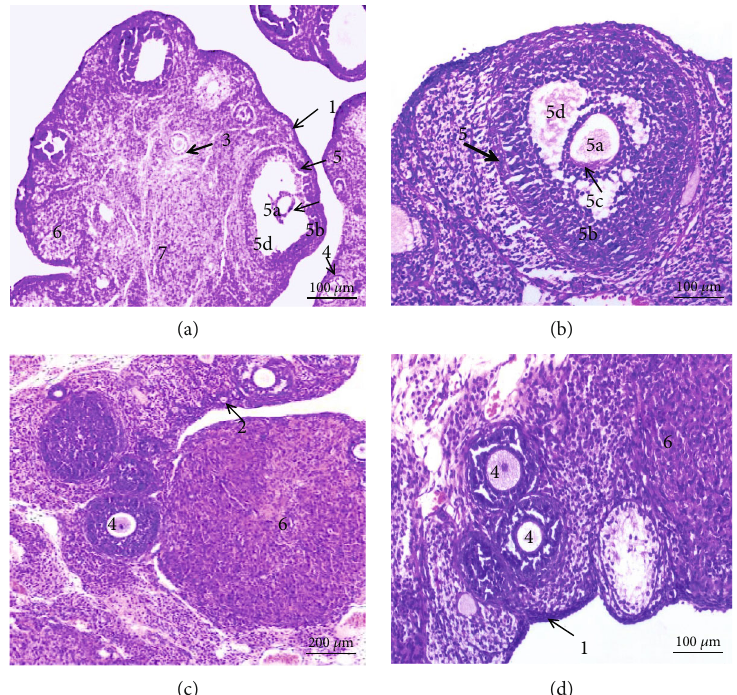
Figure 6: Photomicrographs of control rat ovarian sections: (a) water; (b) CMC; (c) curcumin; (d) stem cells showing normal histological structure. (1) Germinal epithelium; (2) primordial follicles; (3) primary follicles; (4) secondary follicles; (5) mature (antral or Graa fi an) follicle including (5a) oocyte (immature ovum), (5b) granulosa cells (strati fi ed cuboidal epithelium), (5c) zona pellucida, and (5d) antrum; (6) corpus luteum; (7) medulla